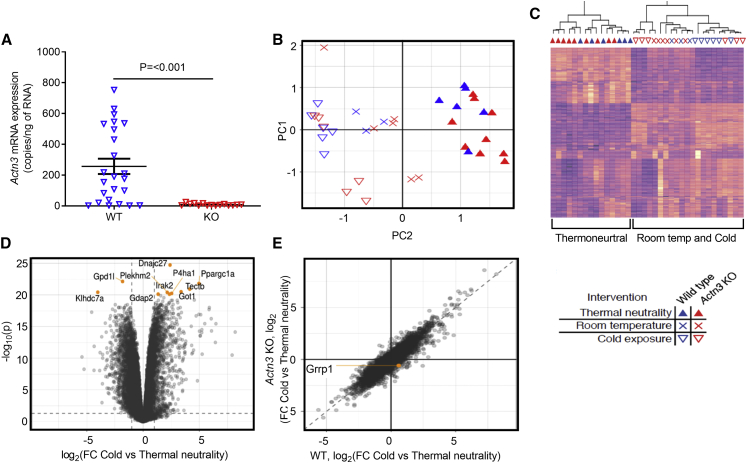
Acute cold exposure induced major, but Actn3 genotype-independent, changes in mouse BAT gene expression(A) Following cold exposure, Actn3 mRNA is present in WT but not in Actn3 KO mice. Plot show values for each WT (blue triangles) and Actn3 KO (red triangles) mouse and mean ± SEM. Statistical difference between the two groups assessed with unpaired t test.(B and C) RNA-sequencing analyses show an effect of temperature but no effect of Actn3 genotype on BAT gene expression with both the principal component analysis (PCA) and heatmap. Description of symbols below heatmap refers to both PCA (B) and heatmap (C).(D) Volcano plot of altered genes confirms that marked changes in BAT gene expression occurs following acute cold exposure, with >2,000 differentially expressed genes identified. Genes showing the largest changes are specified in Table S2.(E) Interaction plot shows no general difference based on Actn3 genotype in BAT following acute cold exposure.